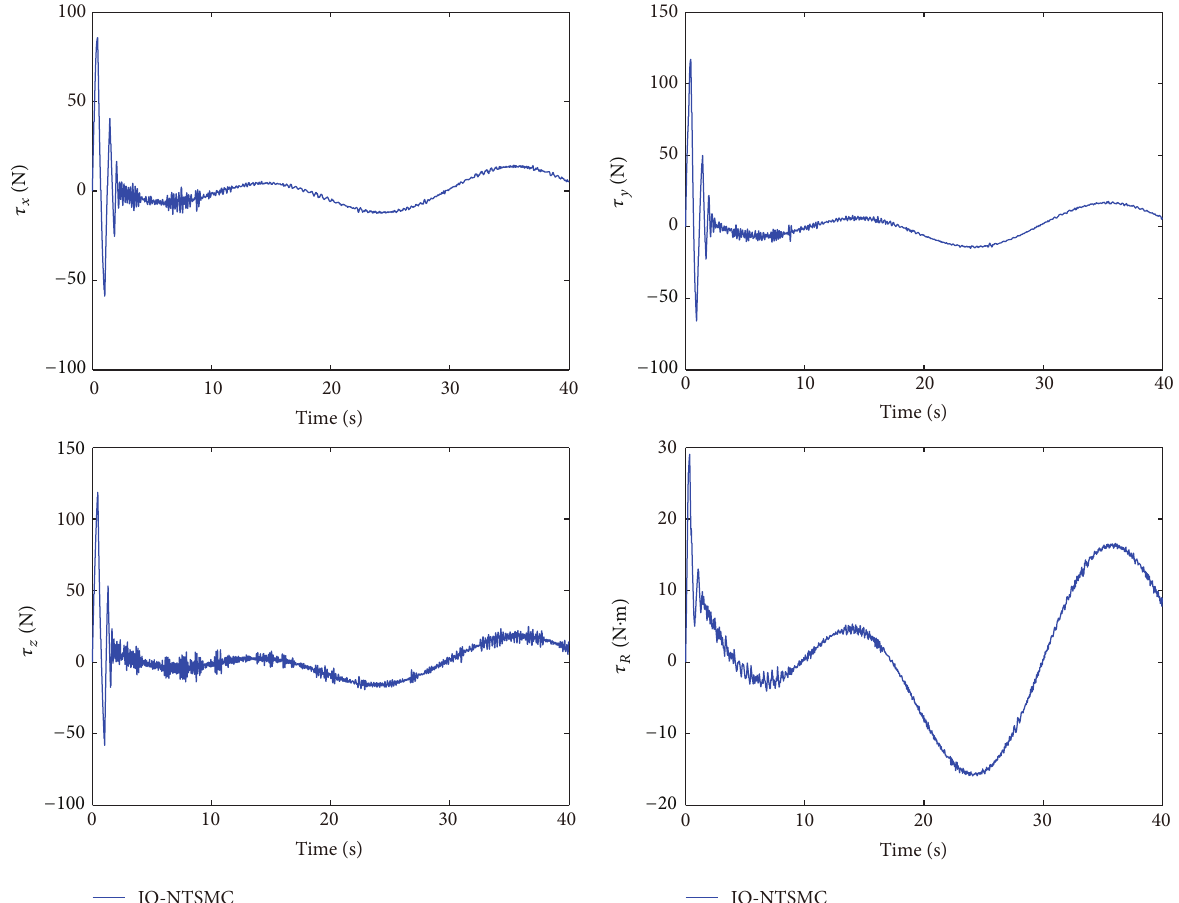
Figure 17: Control inputs of output feedback IO-NTSMC with boundary